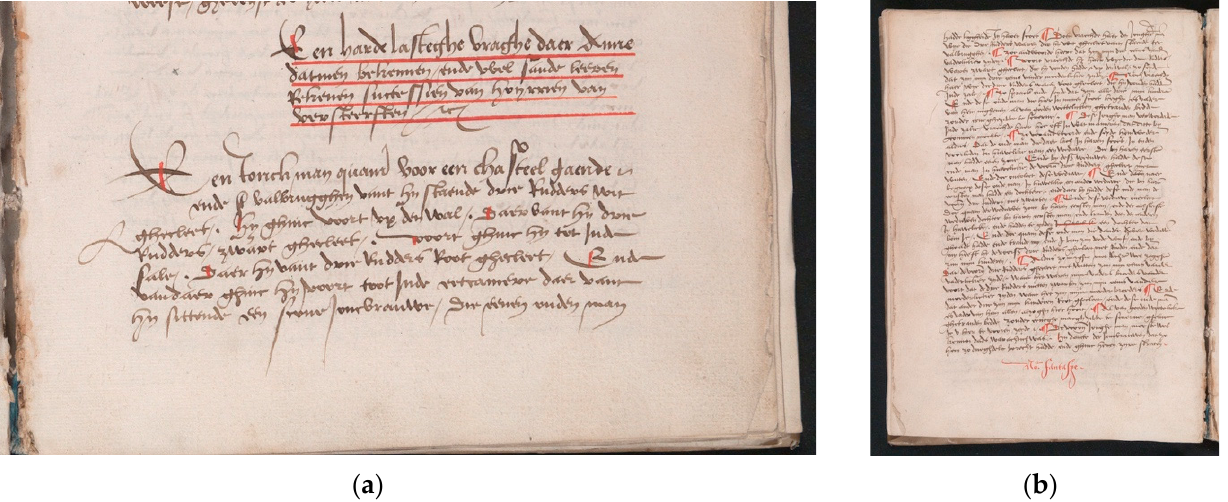
Figure 15. ( a , b ) The riddle of young woman, the old man and the knights in white, black and red in